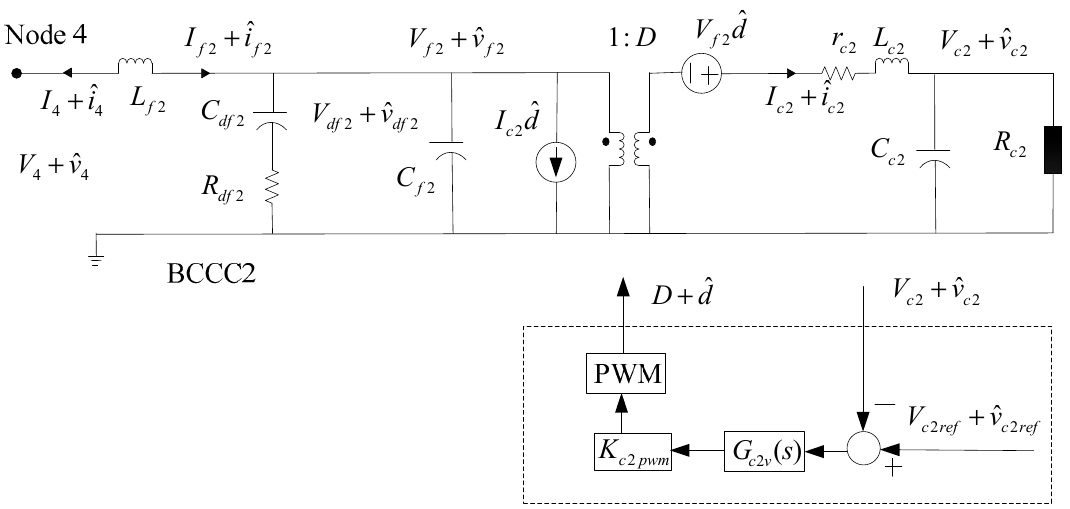
Figure 4. The small-signal model of the CPL with an EMI filter.